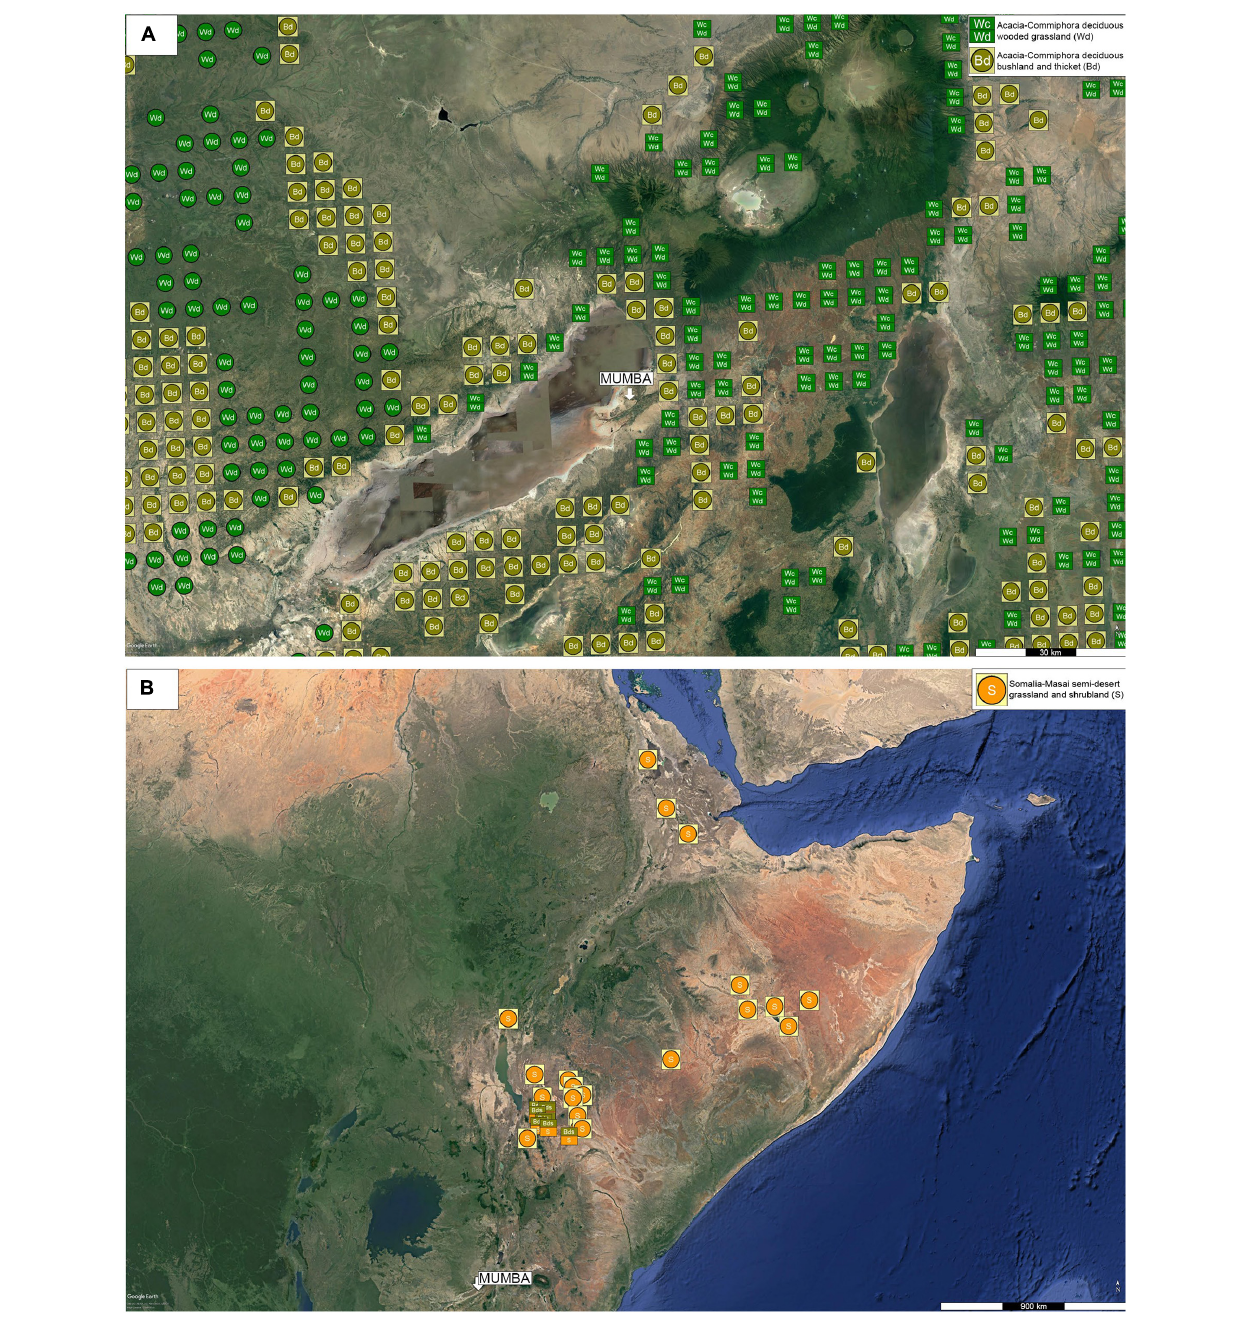
FIGURE 2 | Natural vegetation in the study area according to Kindt et al. (2011). (A) Mosaic distribution of Somalia-Masai Acacia-Commiphora woodland along with wooded grassland engulfing Lake Eyasi and adjacent areas. (B) Location of Somalia-Masai semi-desert shrubland (Google Earth,